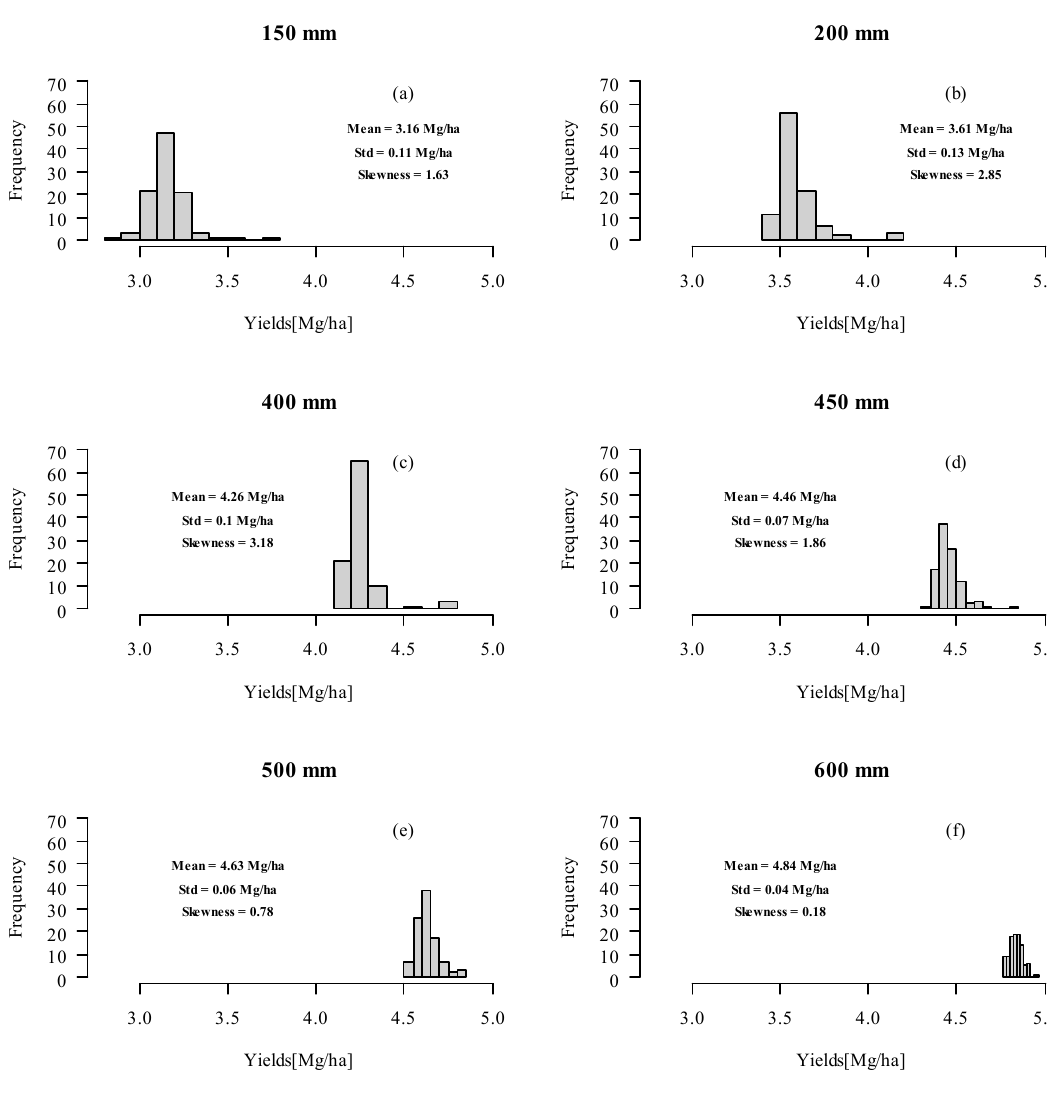
Figure 8. Histogram of distributions of expected yield using water for irrigation of maize in the dry season in Dapaong: ( a ) 150 mm; ( b ) 200 mm; ( c ) 400 mm; ( d ) 450 mm; and ( e ) 500 mm (DS-CDI); and ( f ) 600 mm (DS-FI).